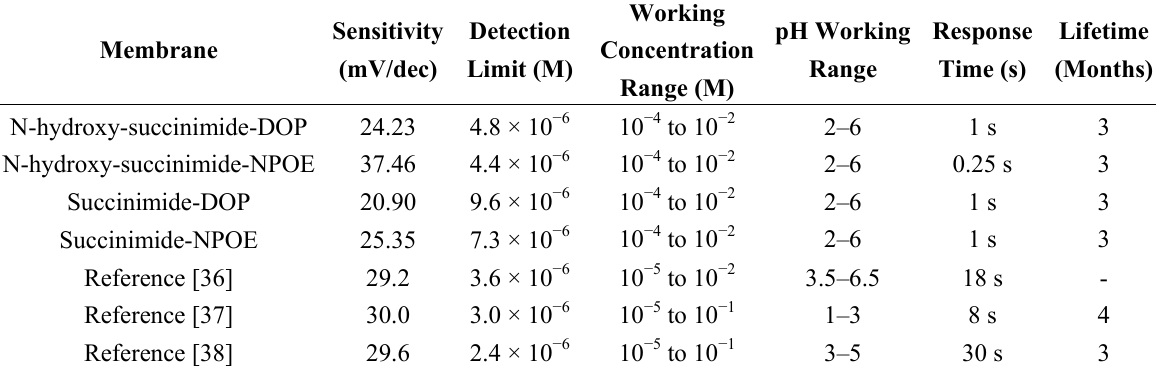
Table 1. Performance characteristics of Cu(II) selective sensors, formulated in this work and from the